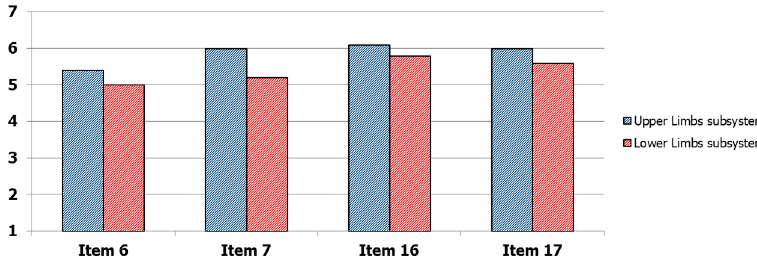
Figure 6. Detail of the mean values of the scores assigned separately for upper limbs subsystem (based on no contact optical devices) and lower limbs subsystem (based on wearable sensors) for the PSSUQ items.